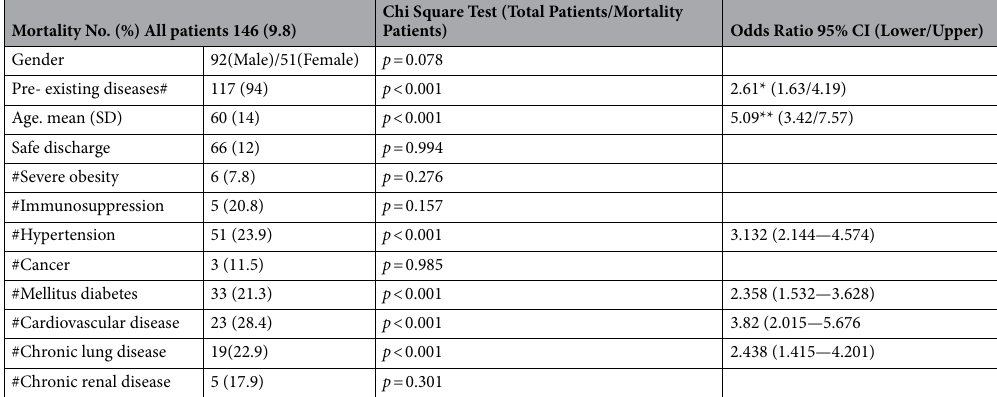
Table 3. Mortality, characteristics of this populations, risk factors. *Compared deceased patients (146) vs total population with information on the history of pre-existing disease (1012). **Odds Ratio for Age group (65 or more/up to 64).